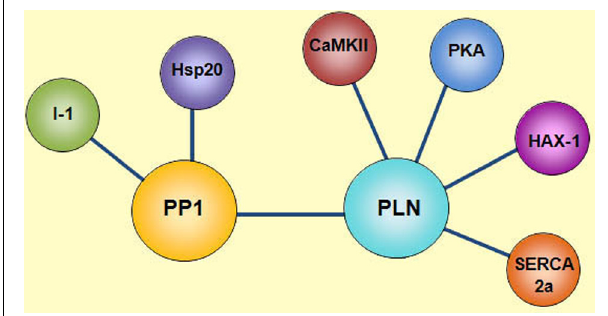
FIGURE 1 | Phospholamban regulatome. Scheme of the multimeric protein complex constituted by SERCA2a, PLN, HAX-1, PKA, CAMKII, PP1, Inhibitor-1 (I-1), and Hsp20, which reversibly regulates SR Ca 2 + transport in the cell. SERCA2a activity is regulated by its reversible inhibitor PLN and the histidine rich Ca 2 + -binding protein (HRC). Phosphorylation of PLN is mediated by cAMP-dependent protein kinase (PKA) at Ser 16 site and Ca 2 + -calmodulin-dependent protein kinase (CaMKII) atThr 17 site. Dephosphorylation of these sites occurs by protein phosphatase 1 (PP1). The activity of PP1 is regulated by inhibitor-1 (I-1) and